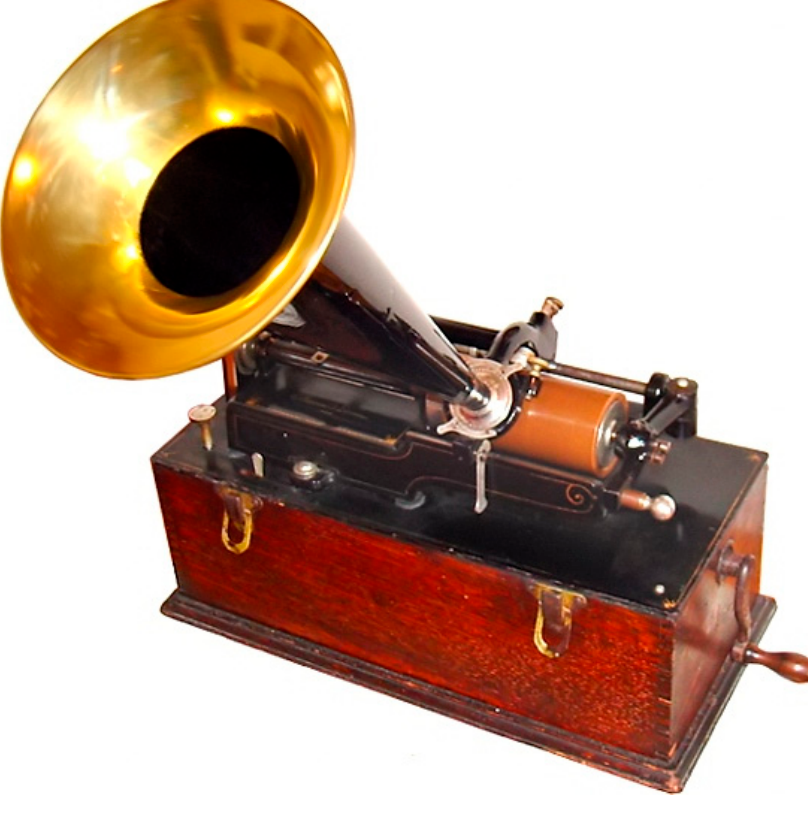
Figure 7. Edison’s phonograph.